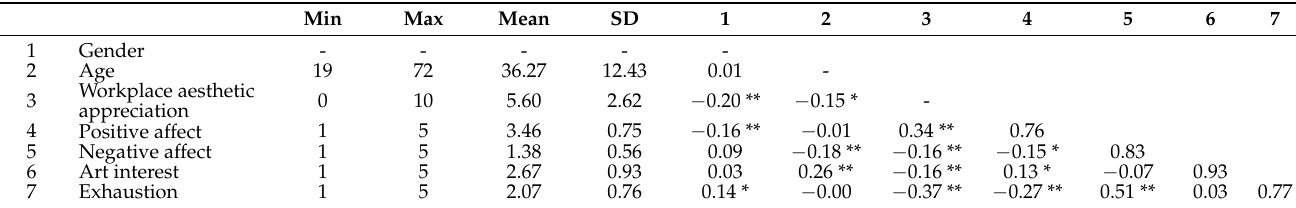
Table 1. Means, SDs, correlations, and Alphas on the diagonal.